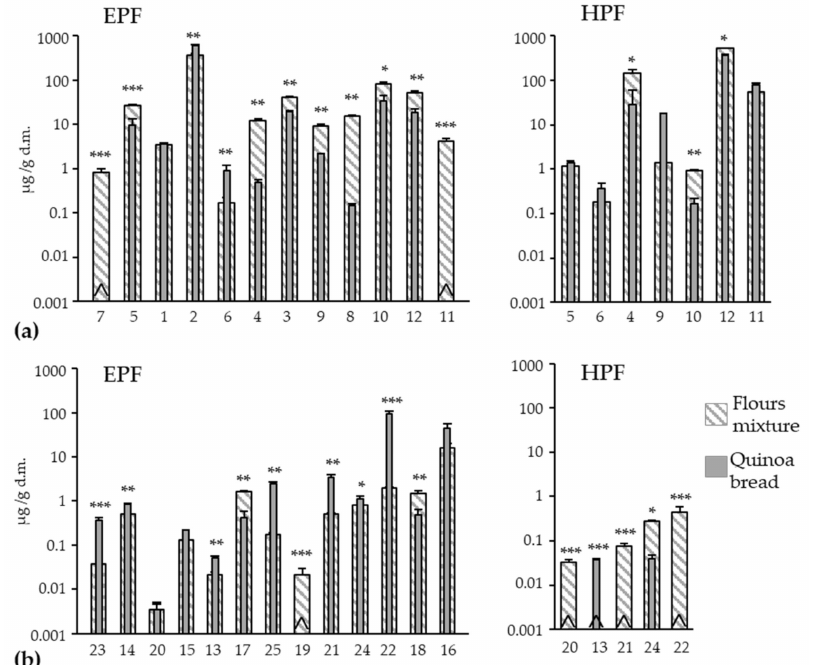
Figure 2. Effect of the bread-making process on the content of each individual phenolic acid ( a ) and flavonoid ( b ) in the respective extractable (EPF) and hydrolyzable (HPF) fractions on quinoa bread. Comparisons were always made between the flours mixture (75% wheat + 25% quinoa) and the quinoa bread values in each compound. *, **, *** denotes significances at p < 0.05, p < 0.01 and p < 0.001, respectively. ˆ not detected. 1 (gallic acid), 2 ( p -hydroxybenzoic acid), 3 (vanillic acid), 4 (syringic acid), 5 (2,4-dihydroxybenzoic acid), 6 (rosmarinic acid), 7 (benzoic acid), 8 (chlorogenic acid), 9 (caffeic acid), 10 ( p -coumaric acid), 11 (sinapic acid), 12 (ferulic acid), 13 (epigallocatechin), 14 (catechin), 15 (epicatechin), 16 (rutin), 17 (hyperoside), 18 (quercetin-3-O-glucopyranoside), 19 (kaempferol-3-O-D- glucoside), 20 (daidzein), 21 (luteolin), 22 (quercetin), 23 (apigenin), 24 (naringenin), 25